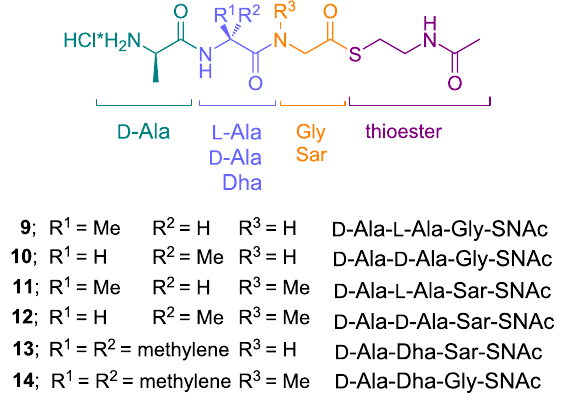
Figure 3: Designed mutasynthons 9 – 14 for argyrin biosynthesis. Peptides are based on three amino acids and additionally bear